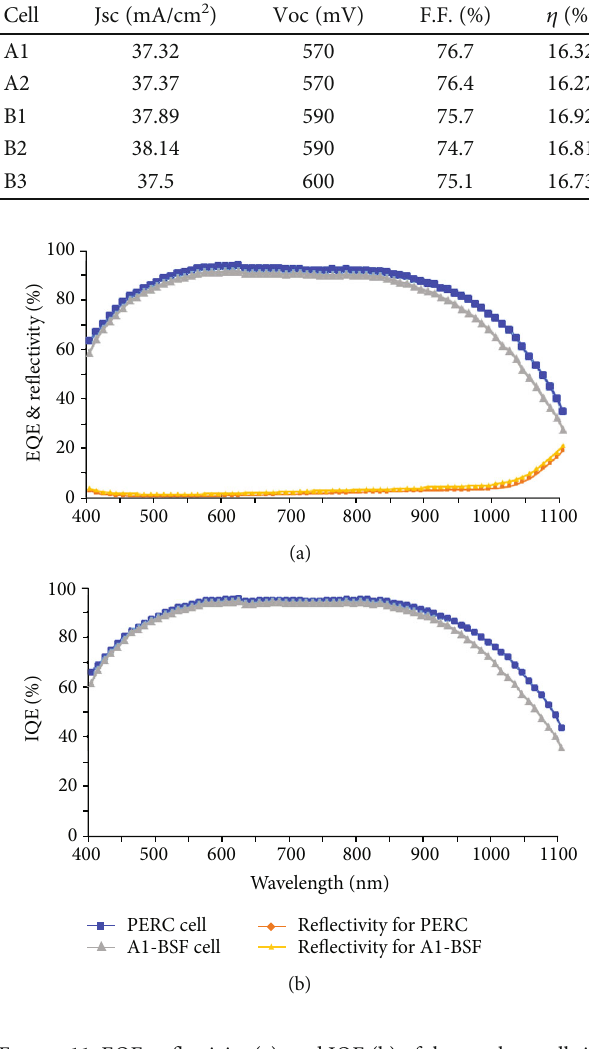
Figure 11: EQE, re fl ectivity (a), and IQE (b) of the two best cells in this